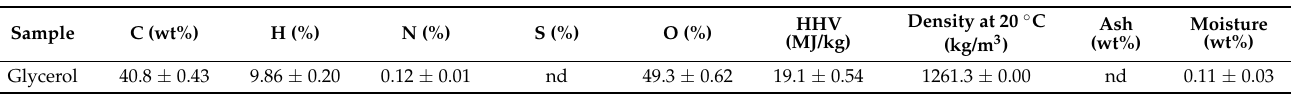
Table 1. Elemental analysis of